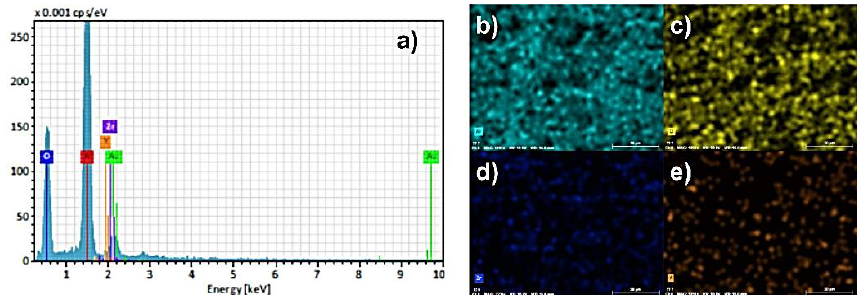
Figure 9. ( a ) EDS spectra of surface fracture of Al 2 O 3 –ZrO 2 ceramics with 1 wt. % of ZrO 2 and corresponding element mappings: ( b ) Aluminum (Al); ( c ) Oxygen (O); ( d ) Zirconium (Zr); ( e ) Yttrium (Y).